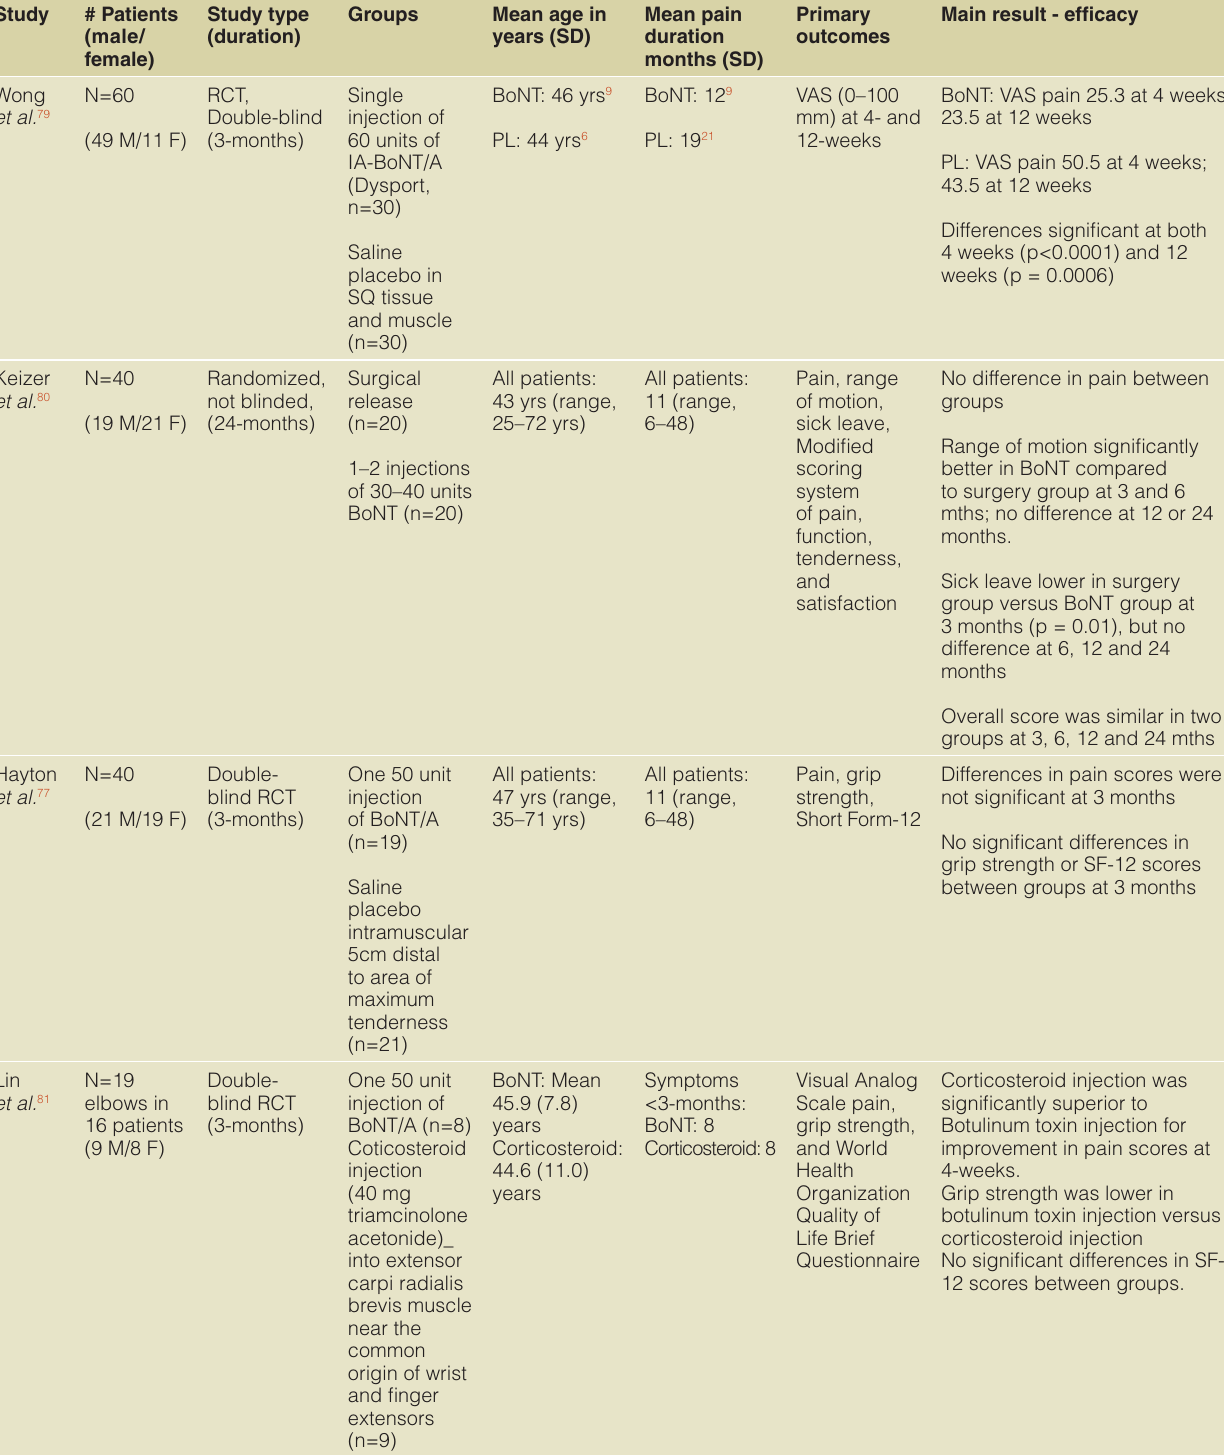
Table 2. Efficacy outcomes of botulinum toxin in tennis elbow in randomized controlled trials.